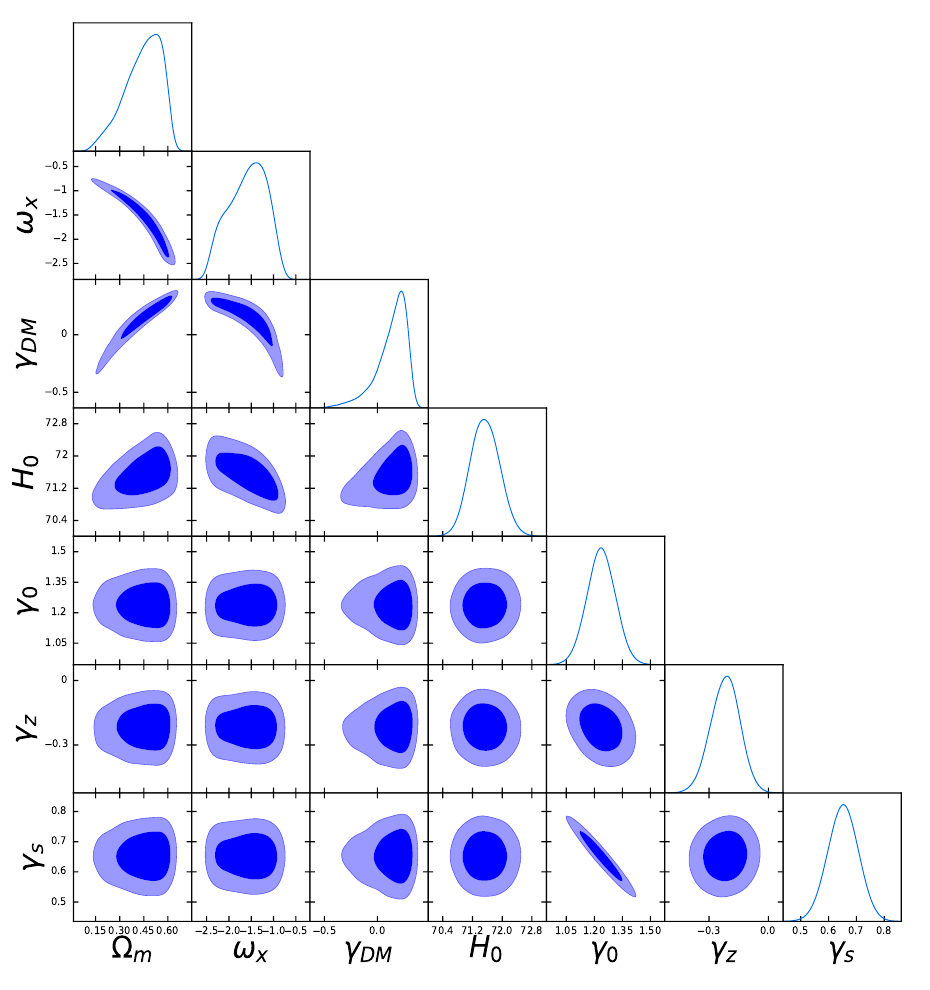
Figure 1 . The 2D contour line are obtained by using